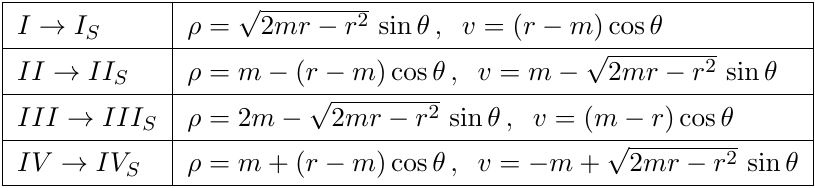
Table 2. Bijective